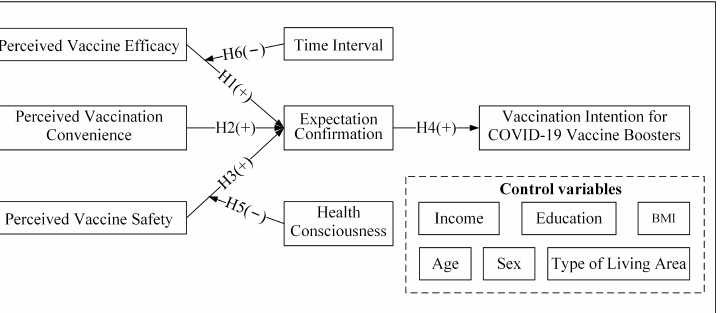
Figure 1. A research model of the factors of the vaccination intention for COVID-19 vaccine